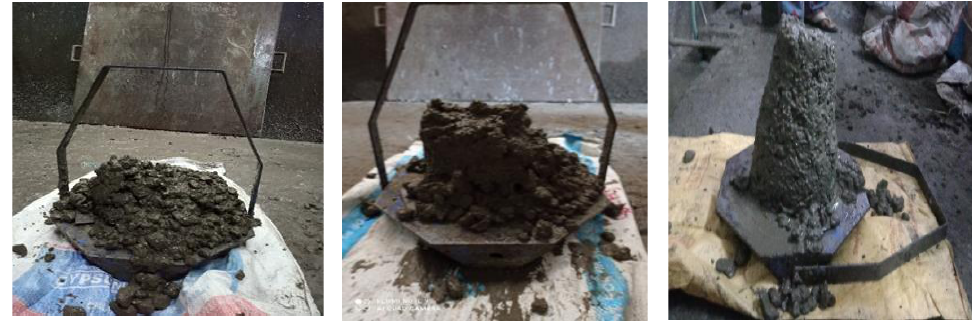
Figure 3. Concrete slump test.